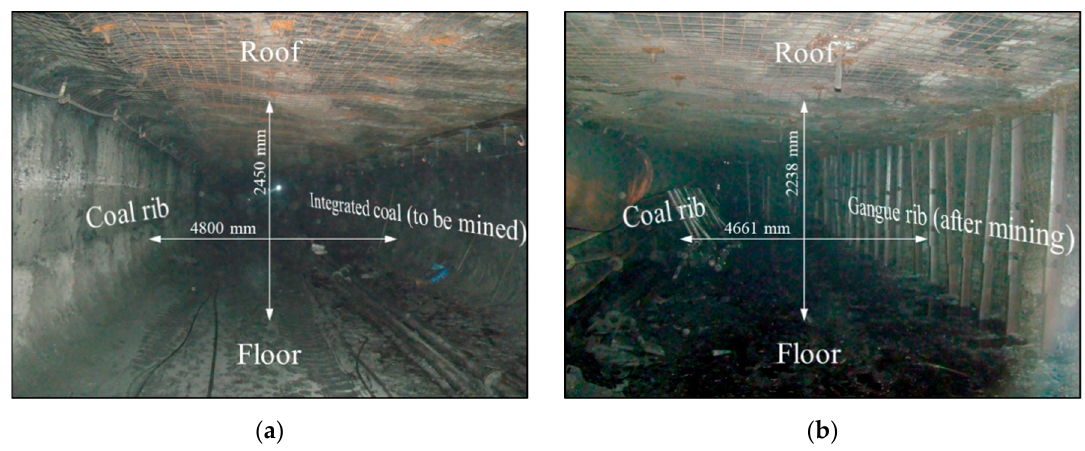
Figure 15. Gob-side entry under the RPGER approach. ( a ) Before retaining; ( b ) after retaining.